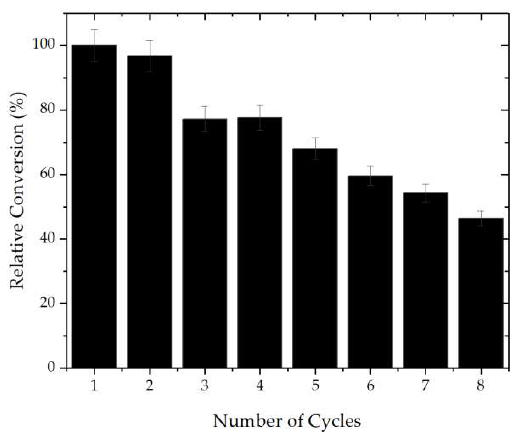
Figure 4. Operational Stability. Reaction medium: CALA-MNP = 208.0 ± 3.0 U / g, 2-ethyl-1-hexanol and free fatty acids from Tilapia oil (1:1) and 2% of content of biocatalyst. The reactions were performed for 24 hours at 30 °C at 200 rpm. Further details are given in Section 4.